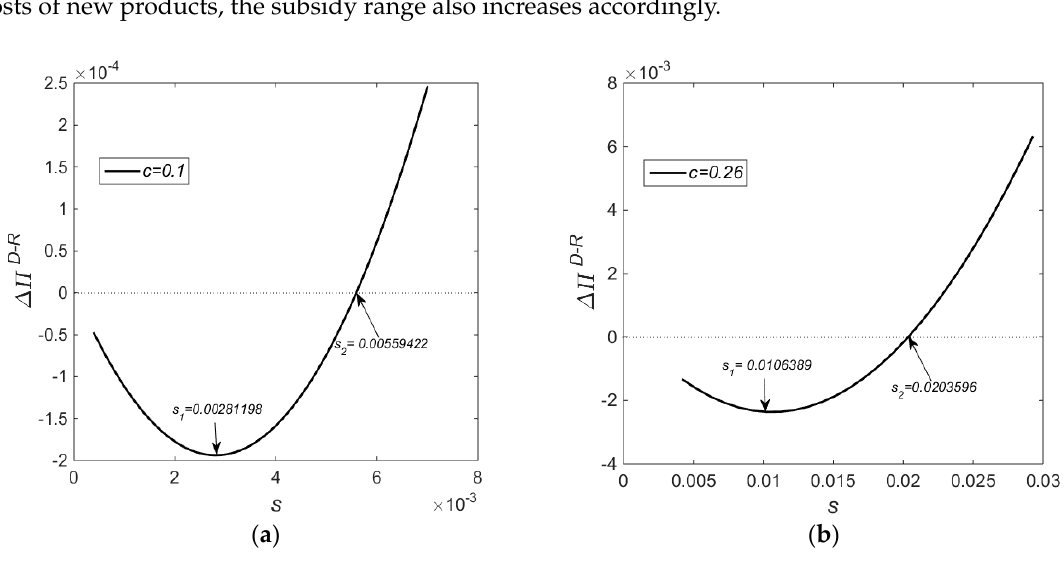
( b ) Figure 2. Impact on the OEM’s Profits by Different Subsidy Levels; ( a )